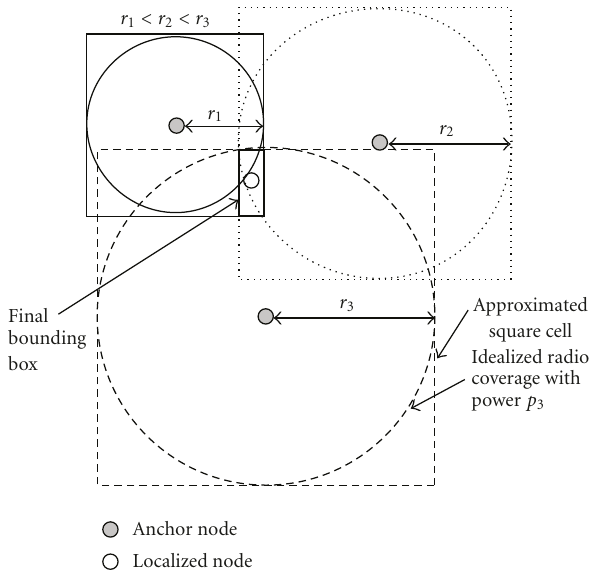
Figure 7: The location resolver algorithm operation principle. A node radio range with a certain transmission power forms a cell. Variable transmission powers are used to introduce variable sized cells. The minimum area that is bounded by the overlapping minimum sized cells around anchor nodes forms the resolved location of the localized node. To simplify calculations, the cells are modeled to be squares.